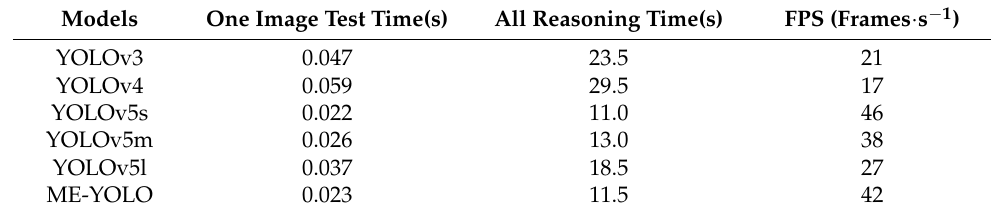
Table 5. Comparison of different models in FPS.